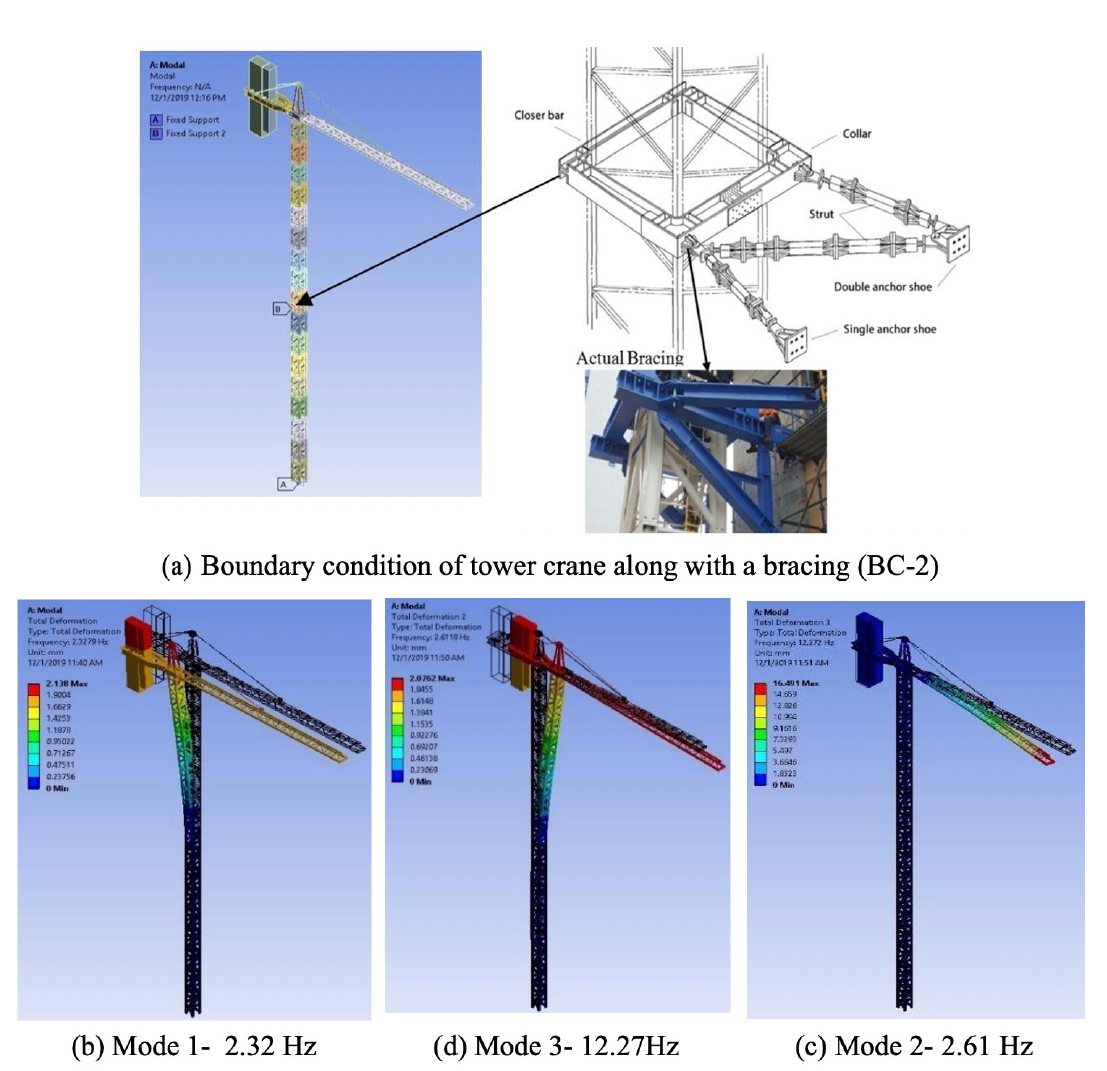
Figure 10. Modal parameters of the Tower crane with one bracing bility which reduced the probability of failure under